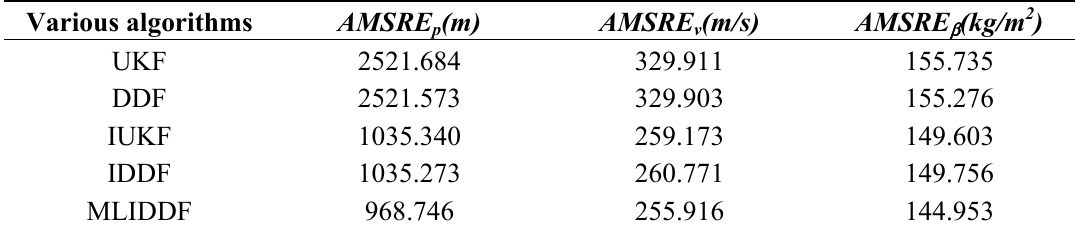
Table 2. AMSRE s for various filters.